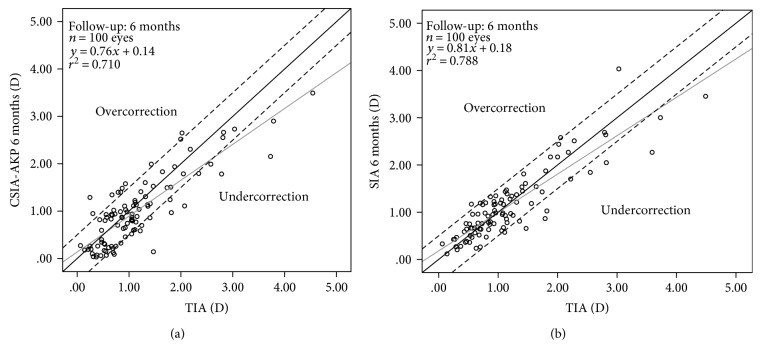
Target-induced astigmatism (TIA) versus surgically induced astigmatism in anterior corneal astigmatism (ACA) (a) and total ocular astigmatism (TOA) (b) at 6 months, expressed as AKP (the astigmatic polar value at the main meridian). Points below the solid black line indicate astigmatic undercorrection. Two dotted lines represent values within ±0.50 D. The solid grey line represents linear regression.